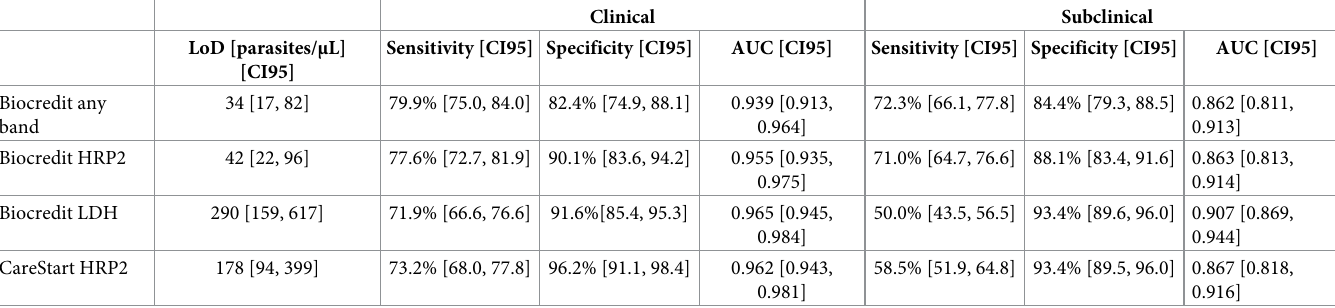
(225/313) for the LDH band ( P < 0.001, Table 2). Specificity was 90.1% (118/131) for HRP2, and 91.6% (120/131) for LDH (Table 2). Among subclinical individuals, the difference in sen- sitivity between HRP2 and LDH was more pronounced than among clinical infections. Sensi- tivity of HRP2 was 71.0% (159/224), compared to 50.0% (112/224) for LDH ( P < 0.001, Table 2). Specificity for HRP2 only was 88.1% (215/244), and for LDH only it was 93.4% (214/ 230, Table 2). Low correspondence between false-positive HRP2 and LDH bands was observed. Among 61 false-positive RDTs (clinical and subclinical combined), only 8 were false-positive for both targets, 34 were positive for HRP2 only, and 19 for LDH only. The LoD, defined as the lowest parasite density that could be detected with 95% probability, was 34 parasites/ μ L (CI95 17, 82) for the Biocredit RDT (any band), 42 parasites/ μ L (CI95 22, 96) for the Biocredit HRP2 band, 290parasites/ μ L (CI95 159, 617) for the Biocredit LDH band, and 178 parasites/ μ L (CI95 94, 399) for CareStart (Table 2, Fig 2). The diagnostic accuracy as measured by AUC analysis was excellent ( > 0.9) among clinical samples for both RDTs and each target on the Biocredit RDT (Table 2). Among subclinical individuals, diagnostic accuracy was very high ( > 0.8) for all RDTs, and reached 0.907 for the LDH band on the Biocredit.